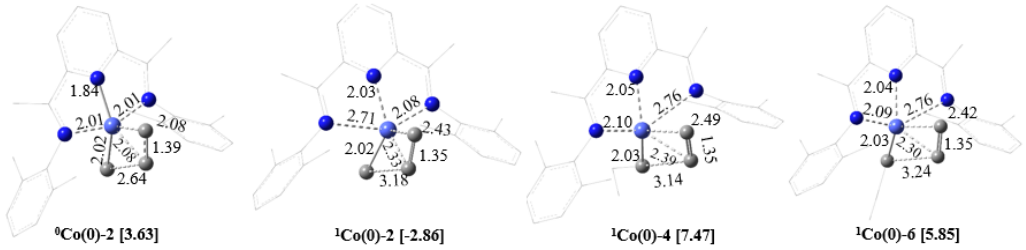
Figure 2. Optimized geometries of the ethylene coordinated cobalt alkyl complexes 1 Co(0)-2 , 1 Co(0)- 4 and 1 Co(0)-6 . (Distances are given in angstrom (Å ), bonding energy is given in the bracket in